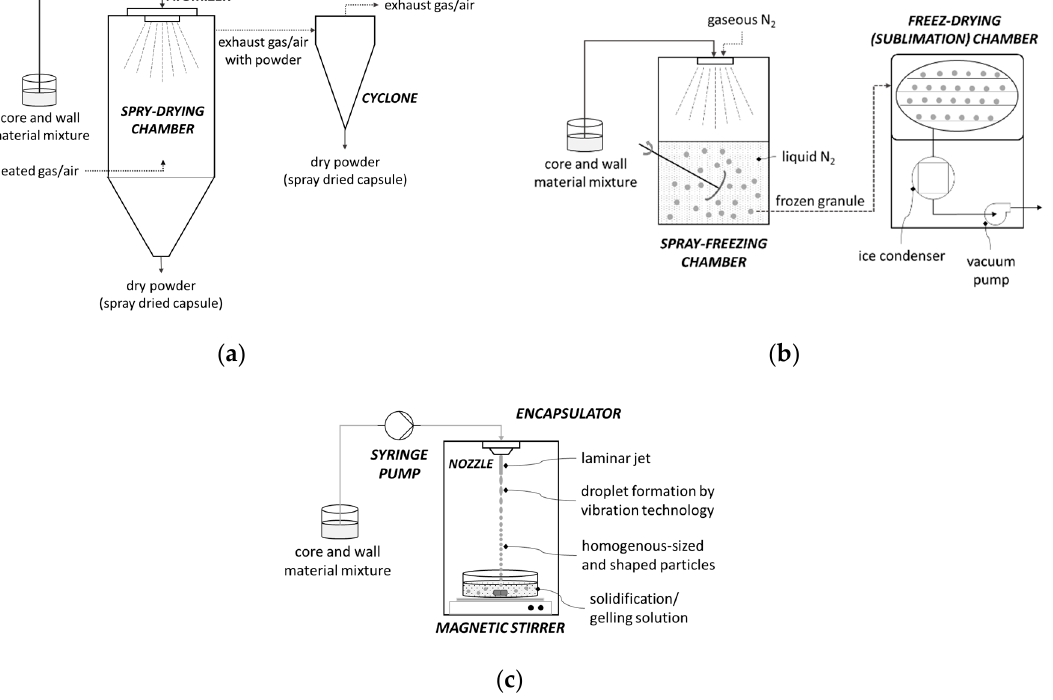
Figure 5. Scheme of some encapsulation procedure: ( a ) encapsulation by countercurrent spray draying, ( b ) encapsulation by freeze-drying (lyofilization), ( c ) encapsulation by extrusion with vibration technology for producing uniform microcapsules.